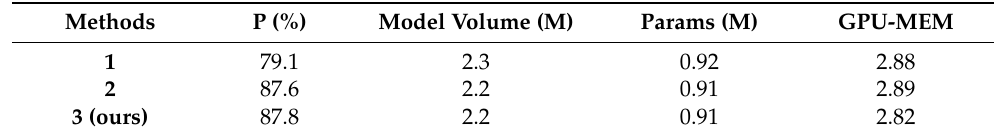
Table 13. The ablation study on the AIR-SARship 1.0 dataset.